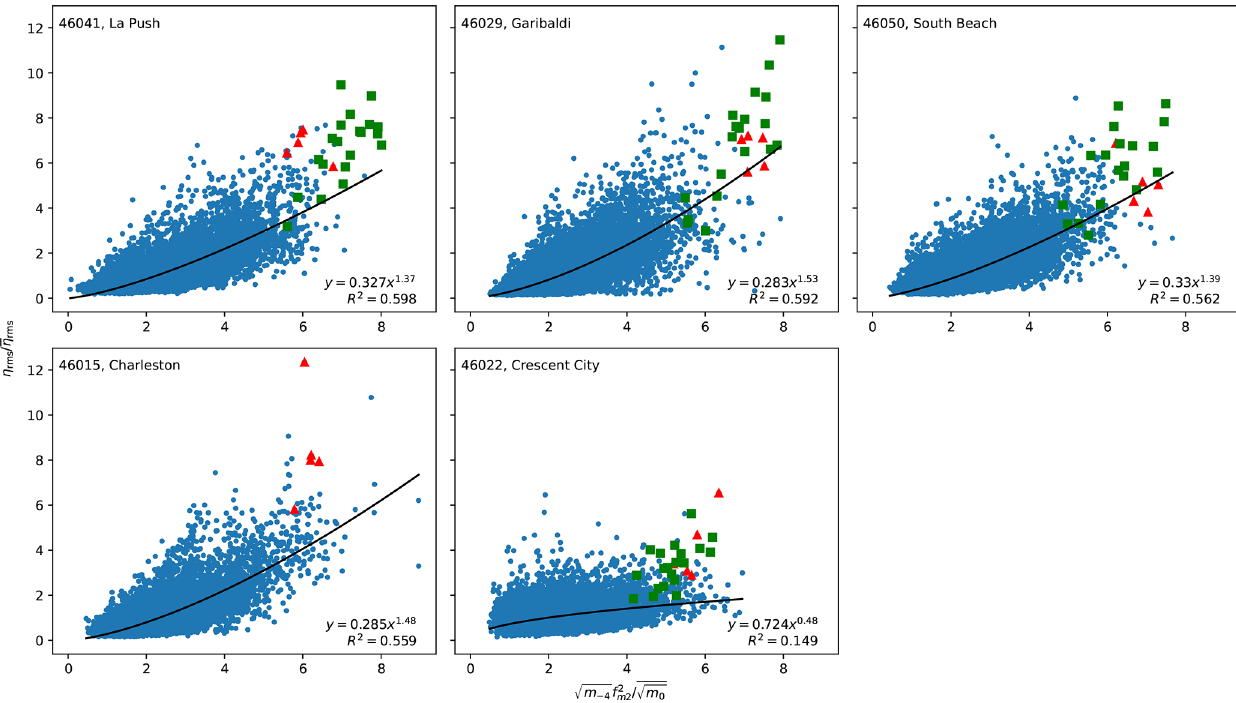
√ √ m − 4 f 2 m 0 from the offshore ocean wave / m 2